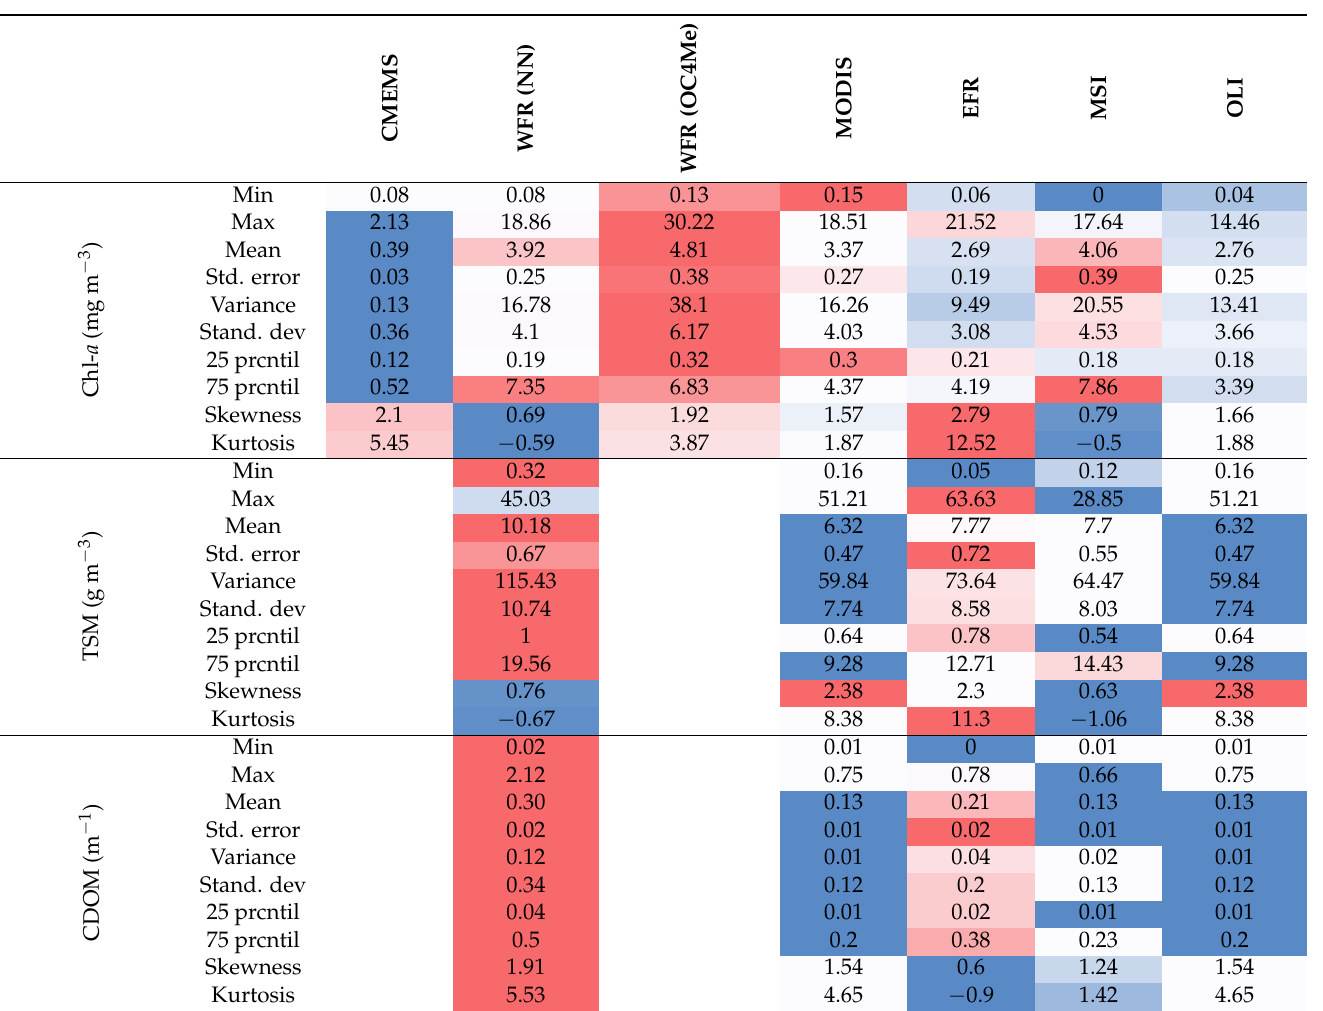
Table 3. Summary Statistics of the Chl- a , TSM, and CDOM contents estimated from the EFR, MSI, and OLI along with the reference standard CMEMS, WFR, and MODIS for the 275 sampling points in the coastal